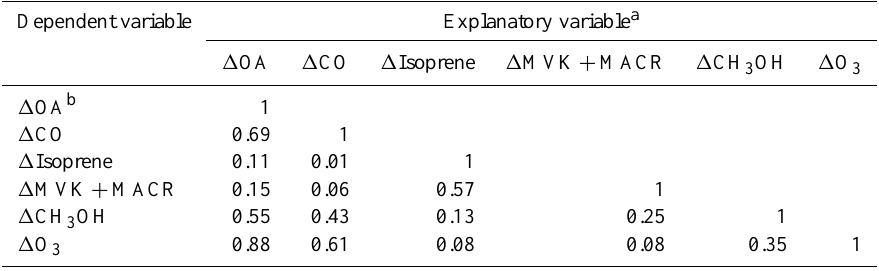
Table 7. Coefficients of determination between plume (cid:49) a values for OA, CO, isoprene, MVK + MACR, CH 3 OH, and O 3 based on data set of 56